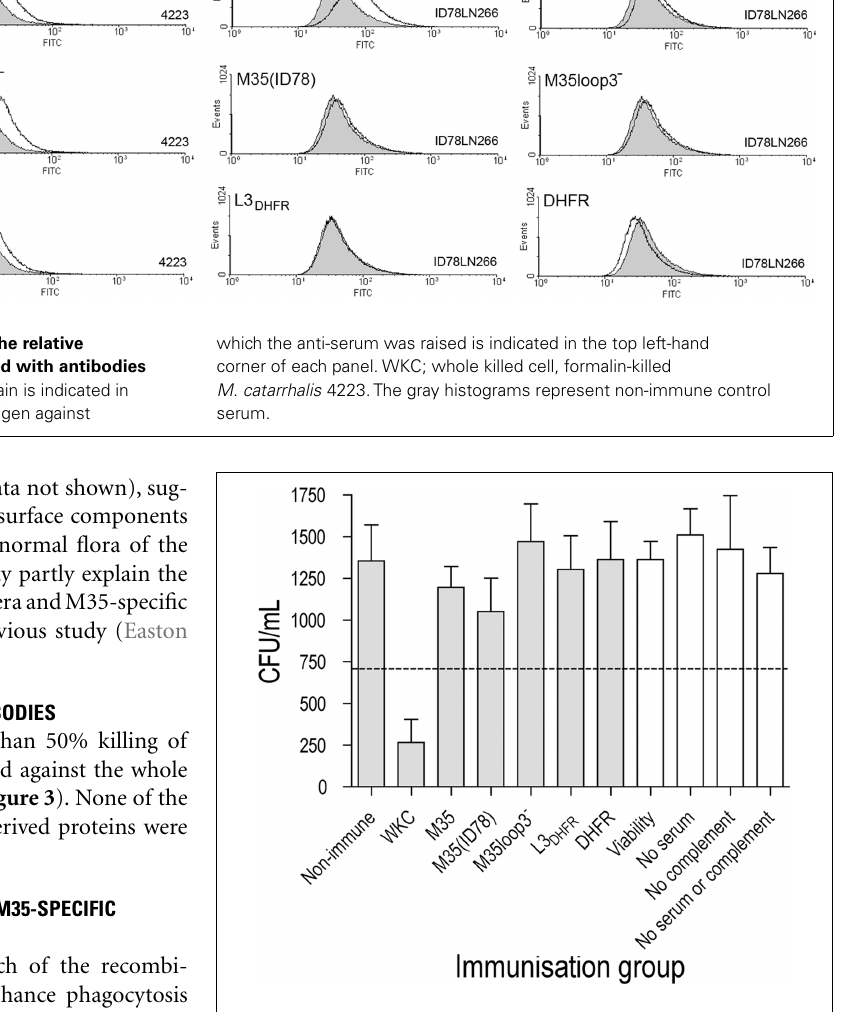
FIGURE 3 | Bacterial recovery after bactericidal killing of M. catarrhalis 2:03KAL mediated by antibodies raised against the M35-derived antigens .Values are the mean of triplicate assays each titrated in duplicate. Error bars show SD.The value equivalent to 50% killing of the cells exposed to serum from non-immunized mice is indicated by the dotted line. Assay controls are unshaded.